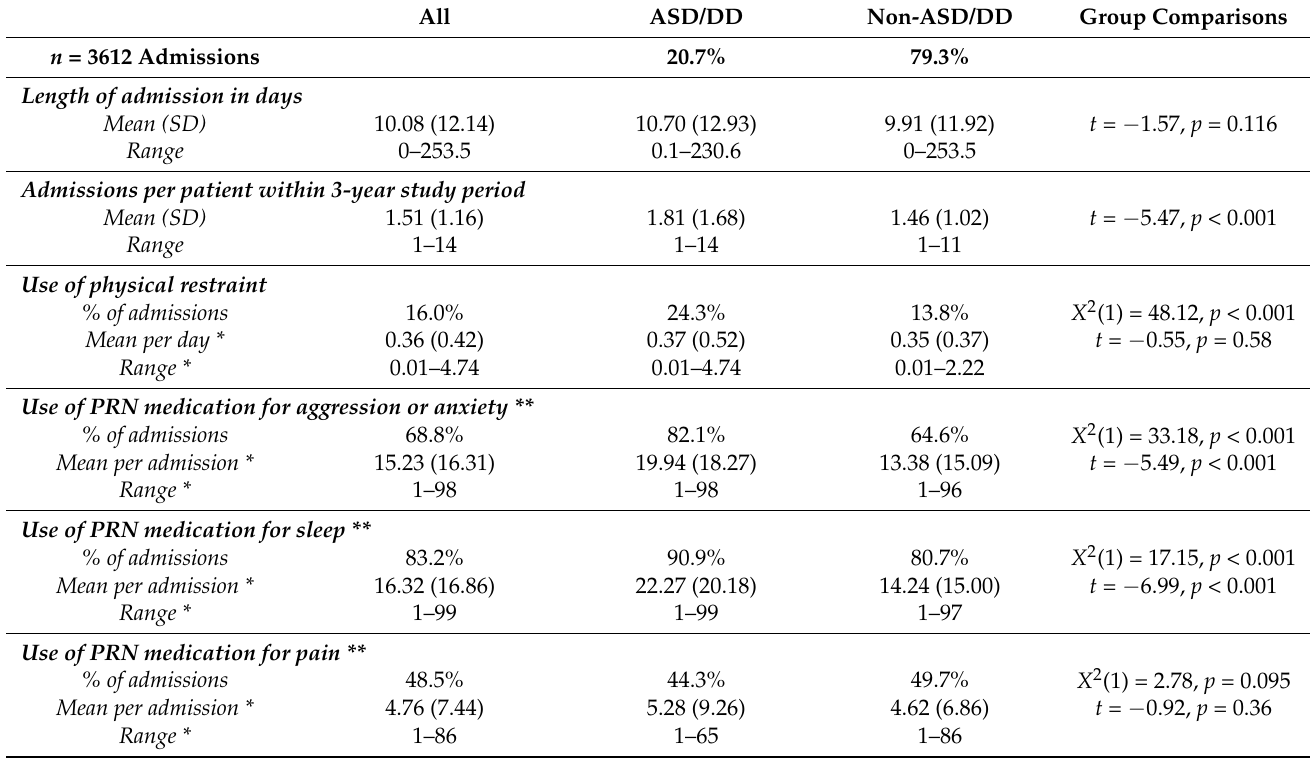
Table 3. Characteristics of clinical care during inpatient admissions among patients with and without